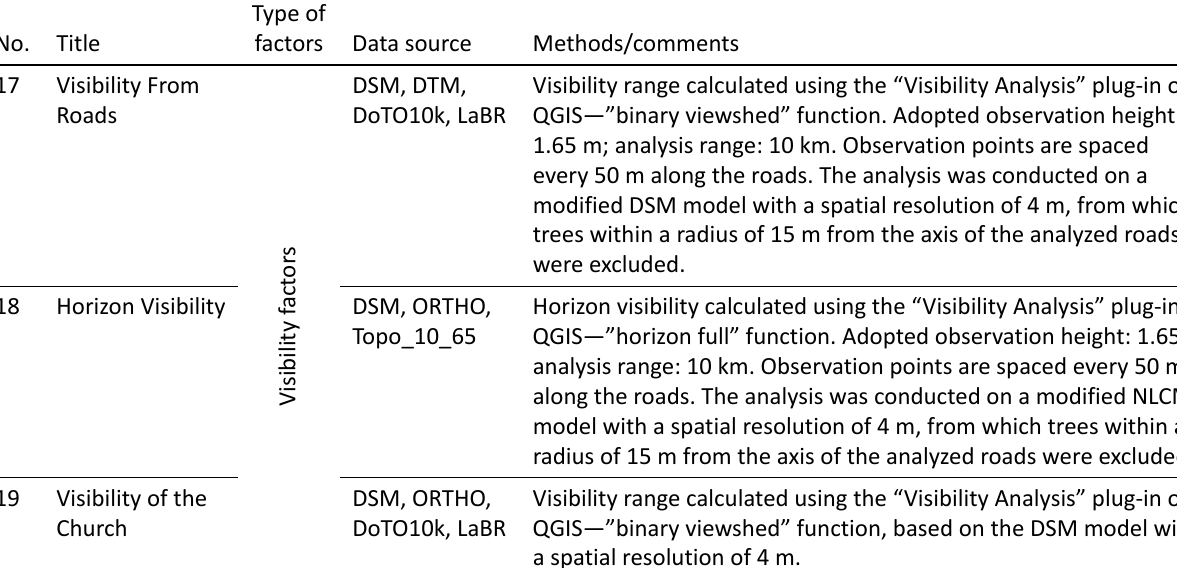
Table 1. (Cont.) List of prepared auxiliary